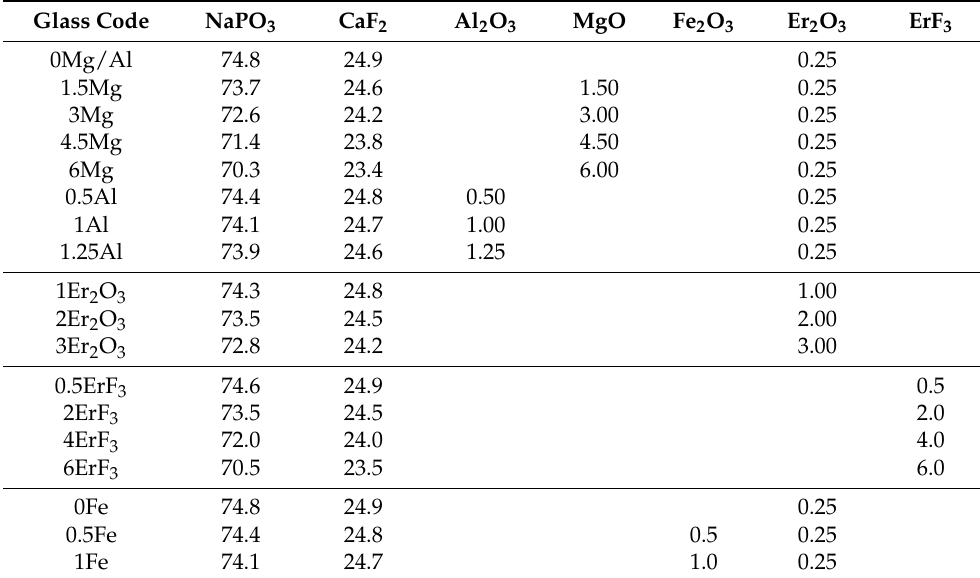
Table 1. Composition (in mol%) and code of the investigated glasses. Glass